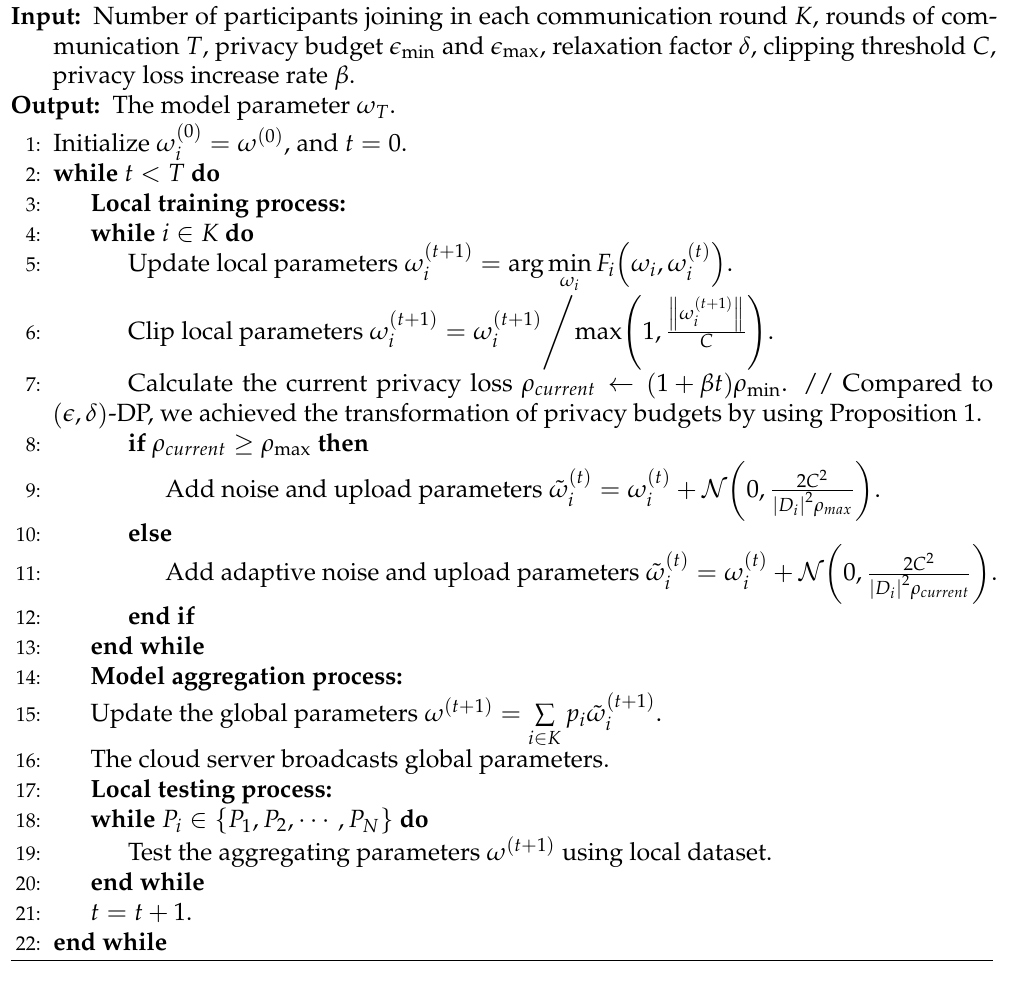
Algorithm 1 Adaptive Differentially Private Multi-Party Learning